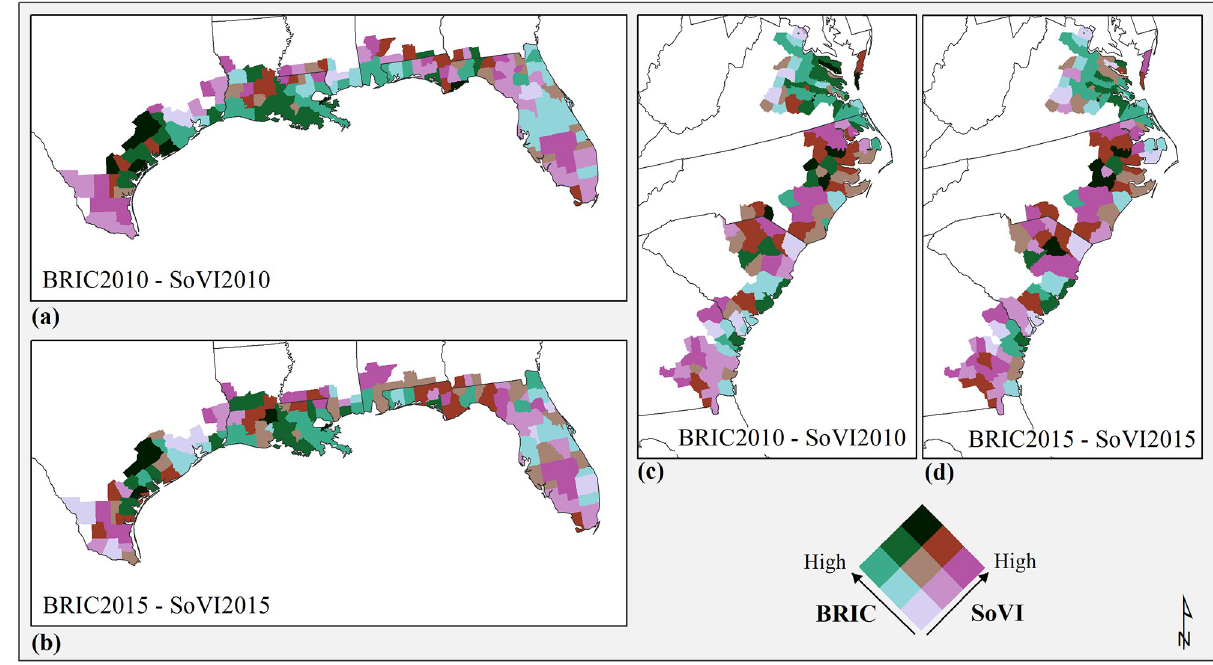
Fig 4. Bivariate maps for BRIC and SoVI Gulf region counties (a) 2010, (b) 2015, and southeast Atlantic coastal counties (c) 2010, (d) 2015. County and state boundaries are retrieved from the U.S. Census Bureau (https://www.census.gov/geographies/mapping-files/time-series/geo/carto-